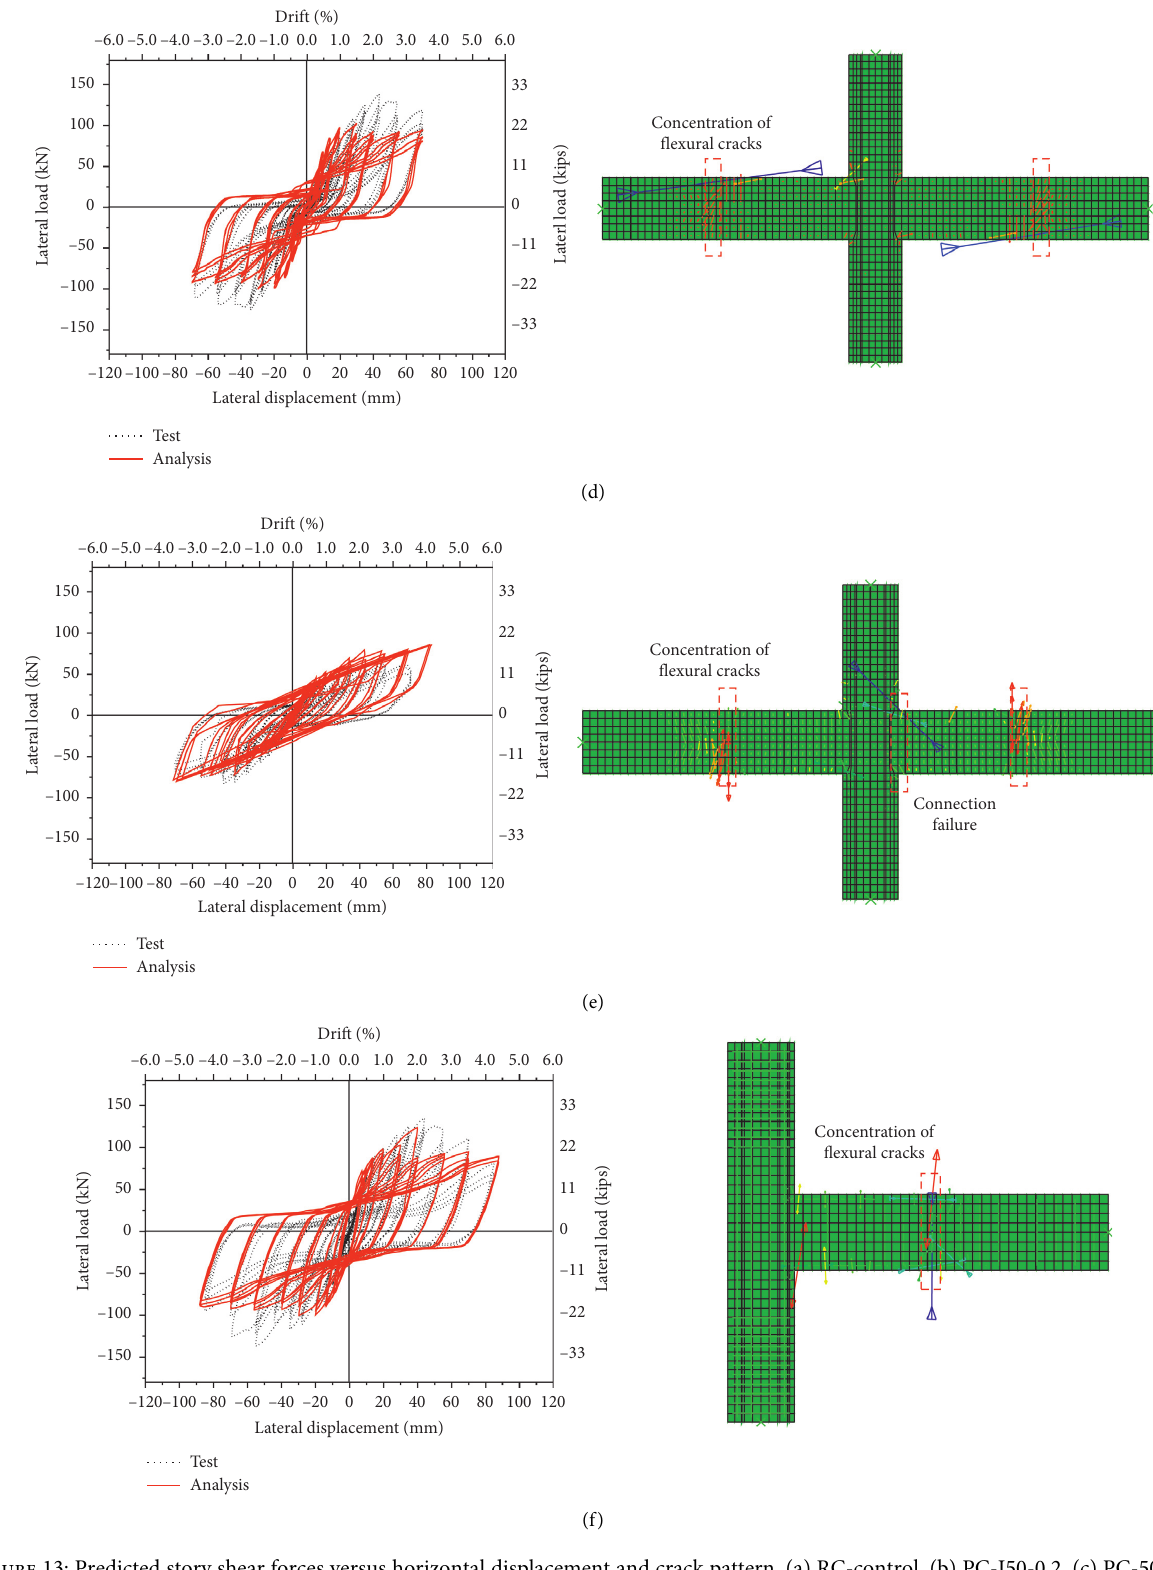
Figure 13: Predicted story shear forces versus horizontal displacement and crack pattern. (a) RC-control. (b) PC-I50-0.2. (c) PC-50H-0.1. (d) PC-I25H-0.1. (e) PC-O50-H-0.1. (f) PC-O25-H-0.1